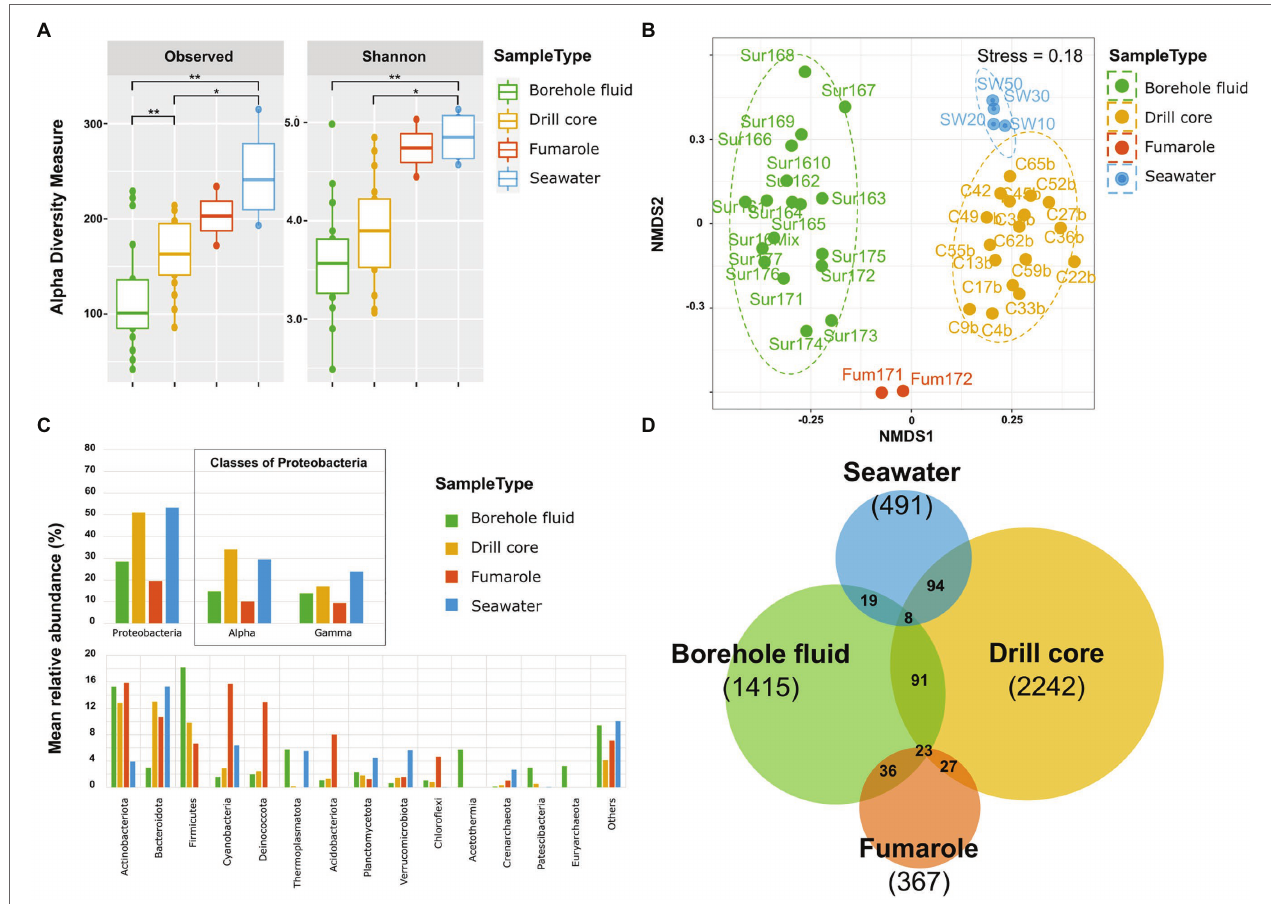
FIGURE 3 | Overview of the microbial community diversity, structure, and composition of the samples types: borehole fluid, drill core, fumarole, and seawater samples. (A) α diversity indices: observed diversity and Shannon’s diversity indexes. Signif. codes: 0.001 “**“0.01 “*”. (B) β diversity assessed with non-metric multidimensional scaling ordination using Bray-Curtis dissimilarity metrics of microbial community within sample types. The stress value equaled 0.18. (C) Mean relative abundance of the 14 most abundant phyla. Proteobacteria are divided into classes. (D) Venn diagram showing the number of shared and unique ASVs among the sample